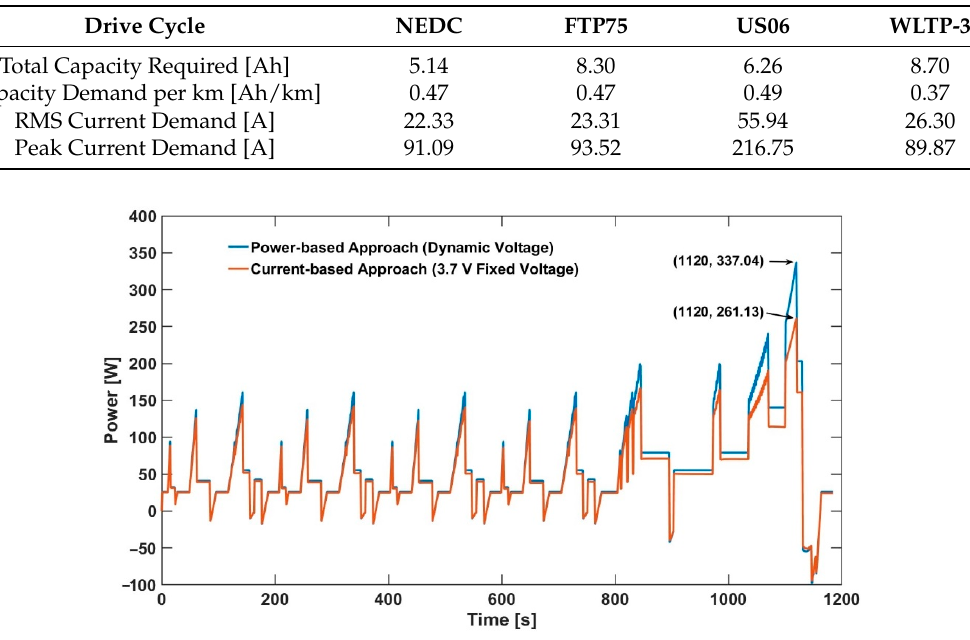
Figure 2. Comparison between power demands for the power-based approach and current-based approach for NEDC at − 15 °C ambient temperature and 65% starting State of Charge (SOC).